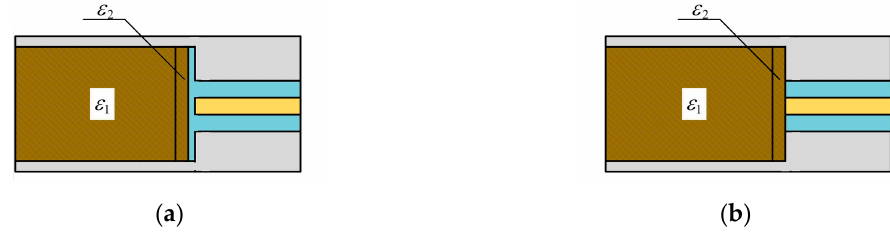
Figure 19. The simulation model for verification e ff ect of the isolation layer: ( a ), with the isolation layer; ( b ), without the isolation layer.